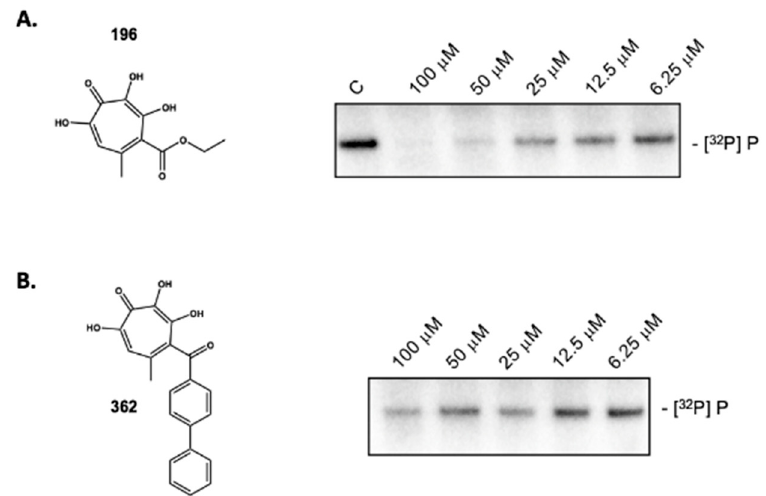
Figure 4. Inhibition of ε -dependent initiation of HBV minus-strand DNA synthesis by 3,7-dHTs. ( A ) 196 and ( B ) 362 . A dose-response analysis is presented for each compound.